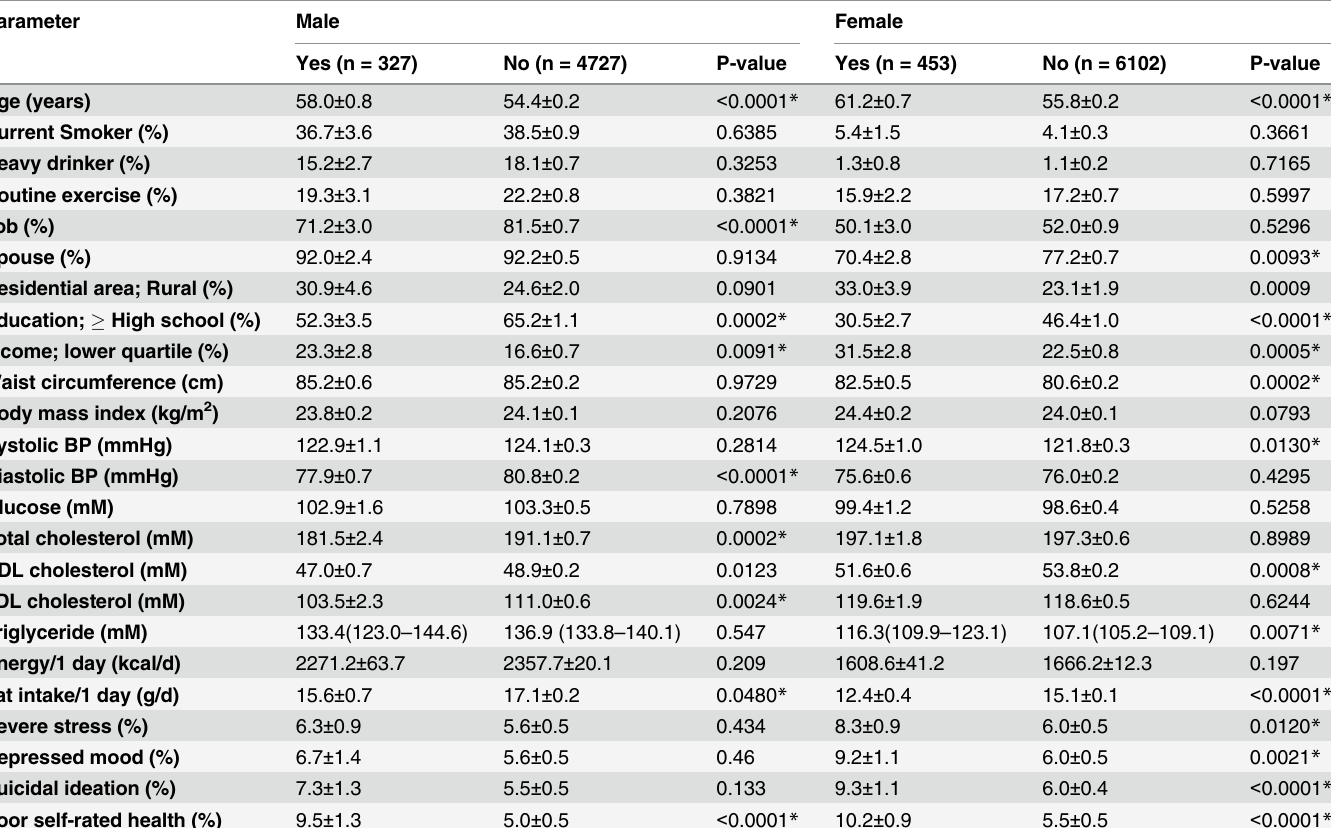
Table 1. Analysis of factors potentially associated with olfactory dysfunction (n =